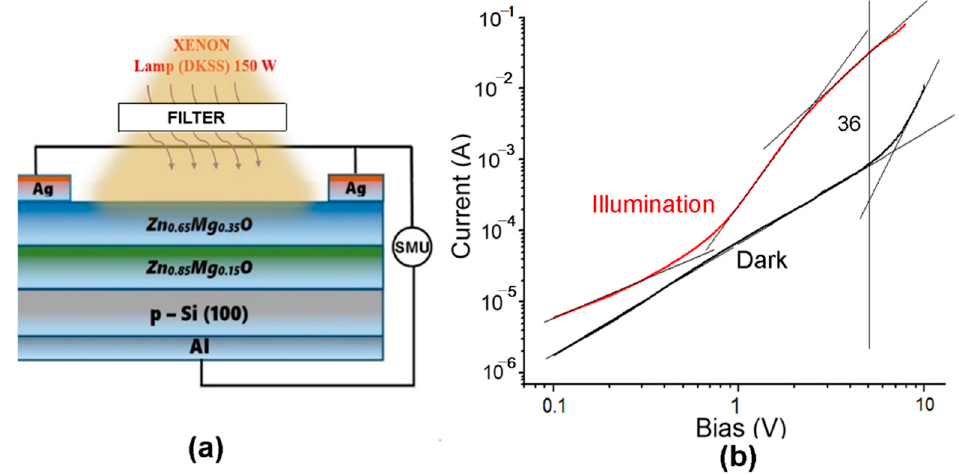
Figure 13. ( a ) Design of an Al/p-Si/n-Zn 85 Mg 15 O/n-Zn 65 Mg 35 O/Ag photodiode. ( b ) Current–voltage characteristics of the device fabricated on films deposited by aerosol spray pyrolysis plotted for the forward bias in a double logarithmic scale.